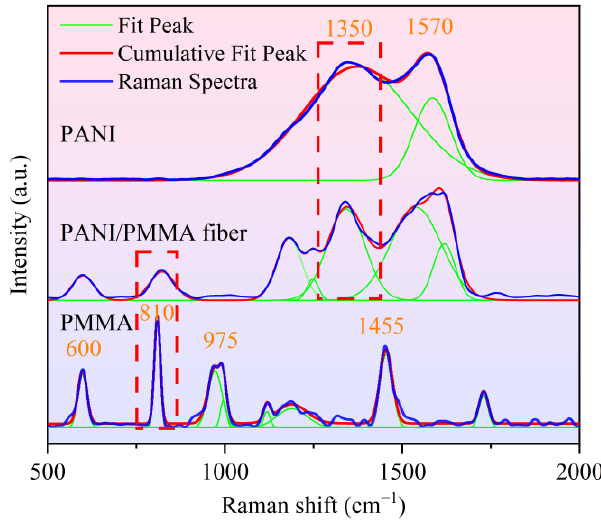
Figure 1. Raman spectra of PANI powders, PMMA fibers, and PMMA/PANI fibers.